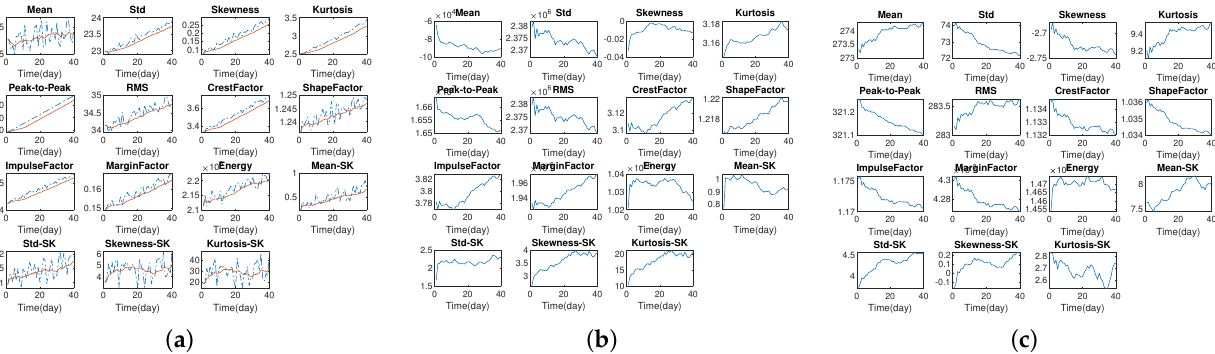
Figure 5. Individual smoothed feature trending, ( a ) torque signals (blue: before smoothing, red: after smoothing), ( b ) current signals, and ( c ) speed